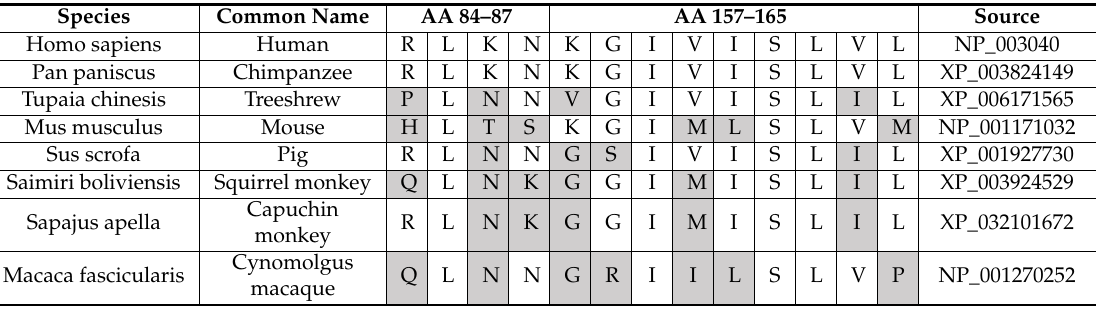
Table 2. Regions of NTCP crucial for HBV binding and